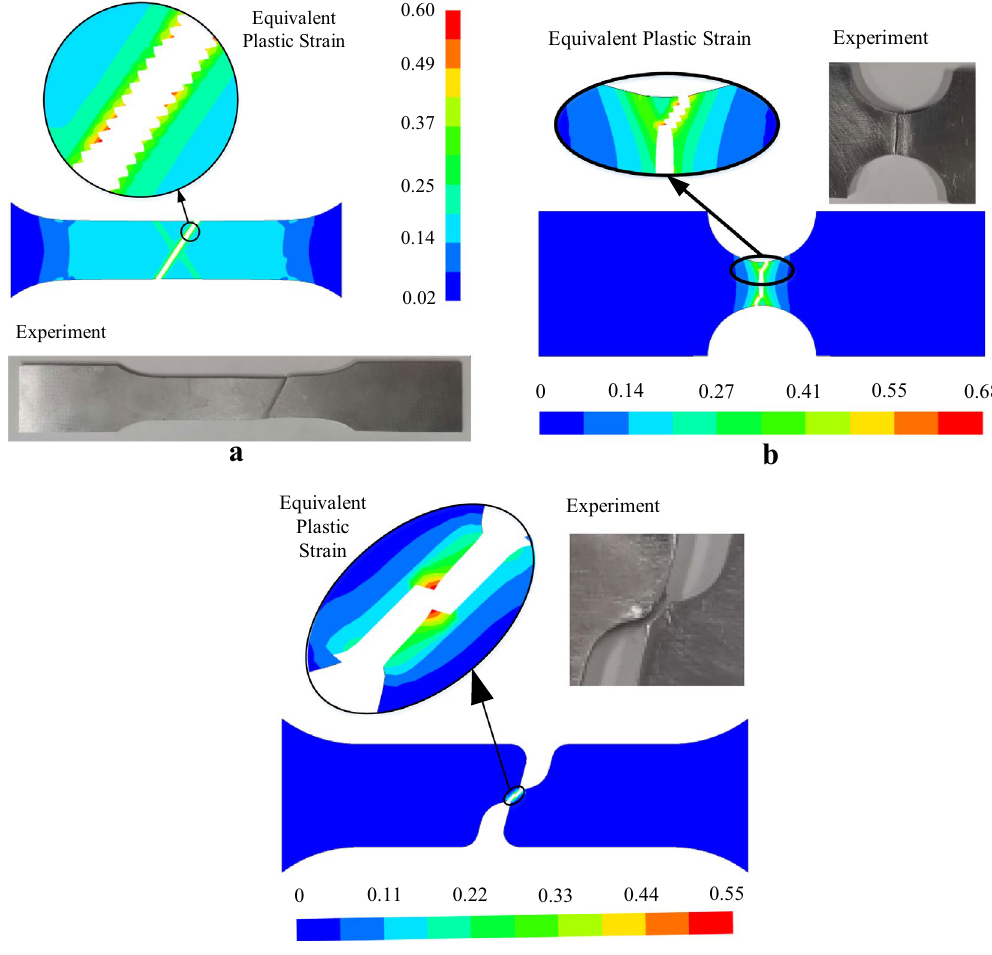
Figure 5 Fracture specimens and equivalent plastic strain nephograms at fracture using the nonlinear relationship Eq. (10) ( r specimen, b N–R10 specimen and c N–45